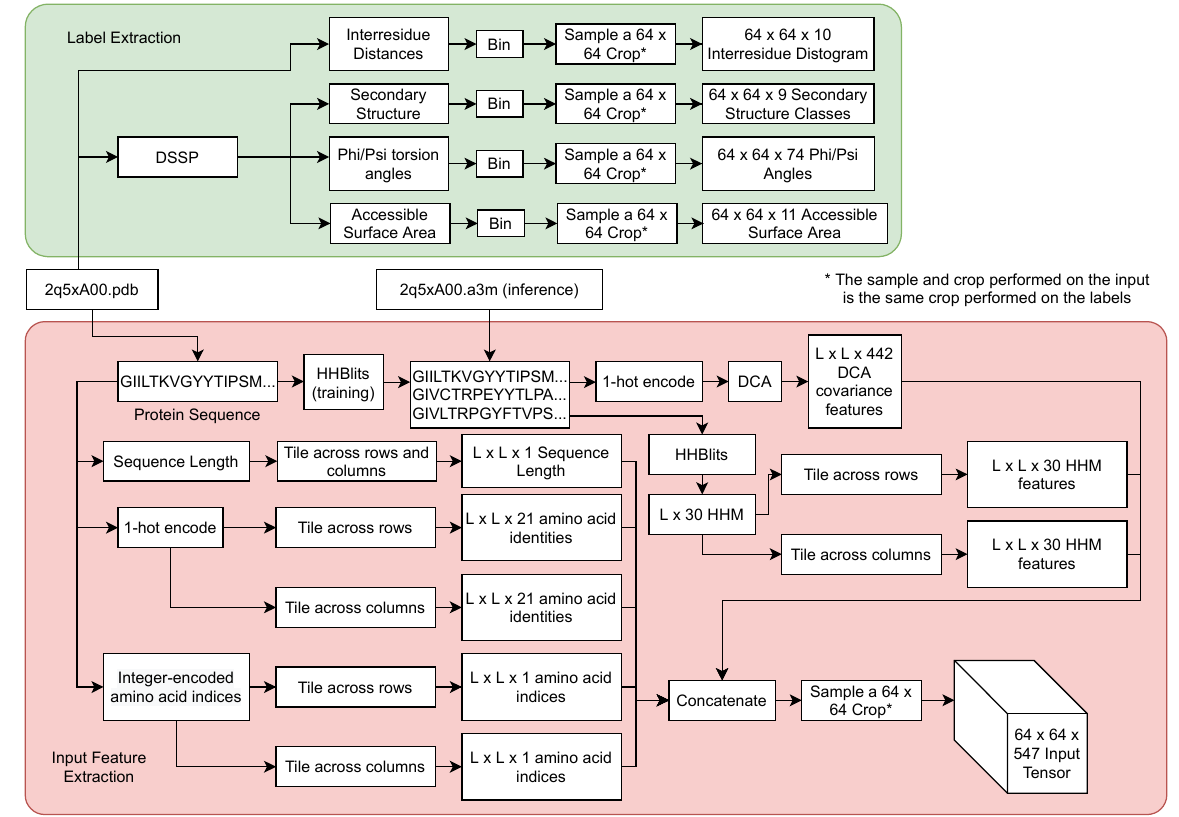
Figure 4. Detailed view of ProSPr data pipeline. For training a protein structure in the pdb file format is used to create inputs and labels. For inference, a multiple sequence alignment in the a3m file format is expected.